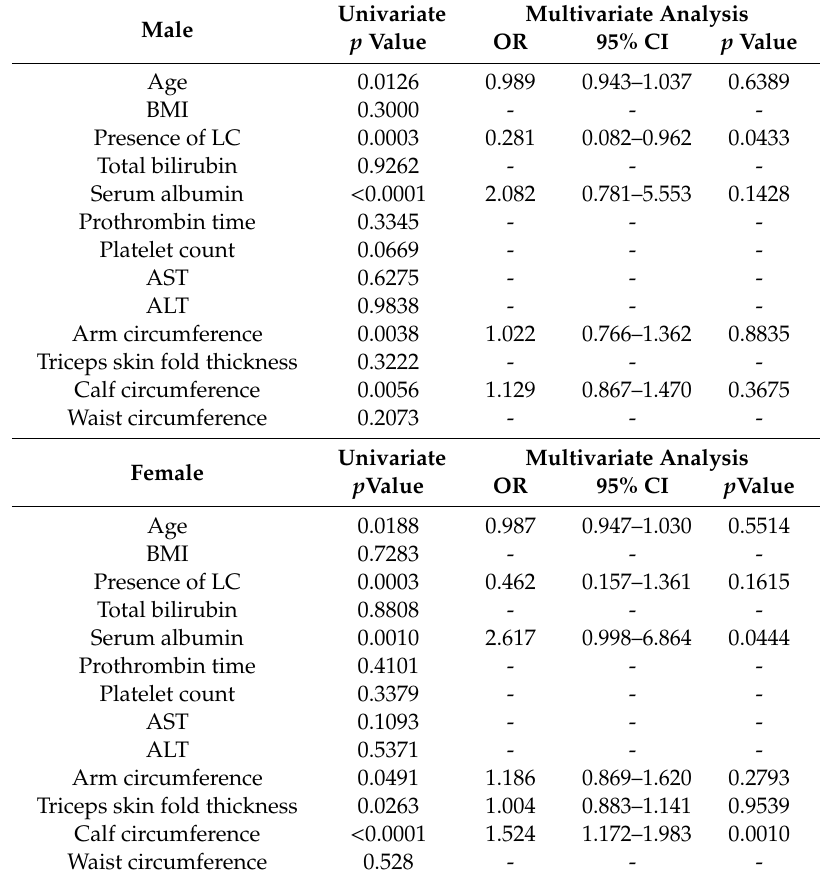
Table 5. Multivariate analyses of factors linked to frailty in male and female